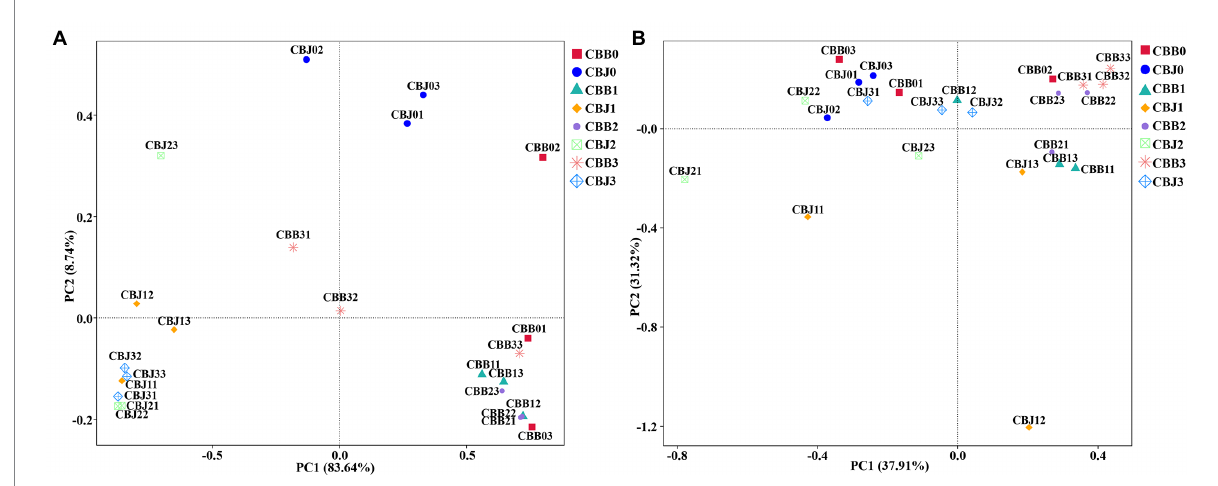
FIGURE 6 Principal coordinate analysis (PCoA) of the microbial communities in tobacco leaves (symptomatic leaves CBB; asymptomatic leaves CBJ) at four sampling time points (The first numbers 0–3 in the sample name represent four different sampling time points, respectively. The numbers 1–3 at the end of the sample name represent three biological replicates.). (A) For fungal communities and (B) for bacterial communities.